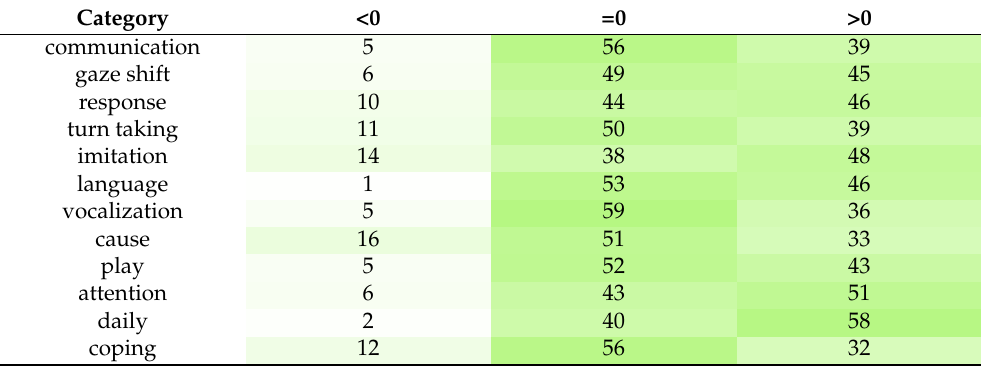
Table 5. Changes in the answers by category. Every row represents a category; columns represent negative, natural, or positive change in